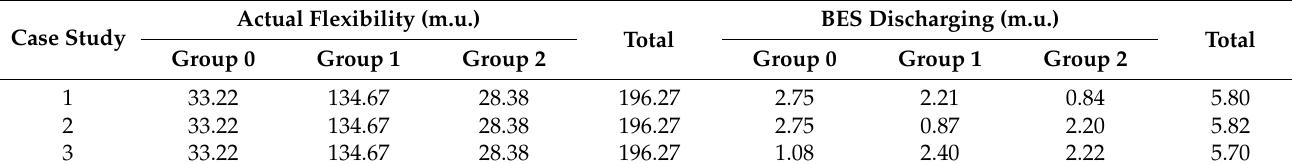
Table 4. Total remuneration according to a single approach.